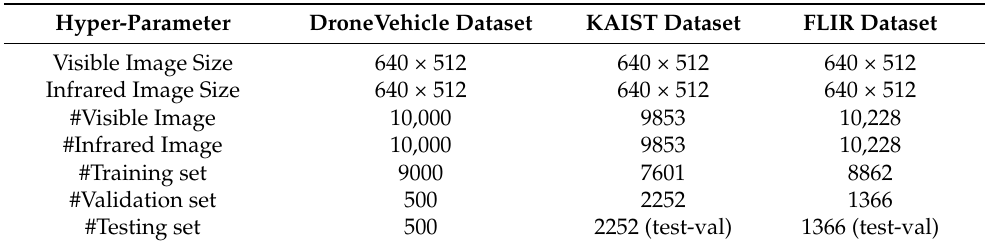
Table 3. The hyper-parameters of the dataset we used in this manuscript. test-val means that the test set used in this article is the same as the validation